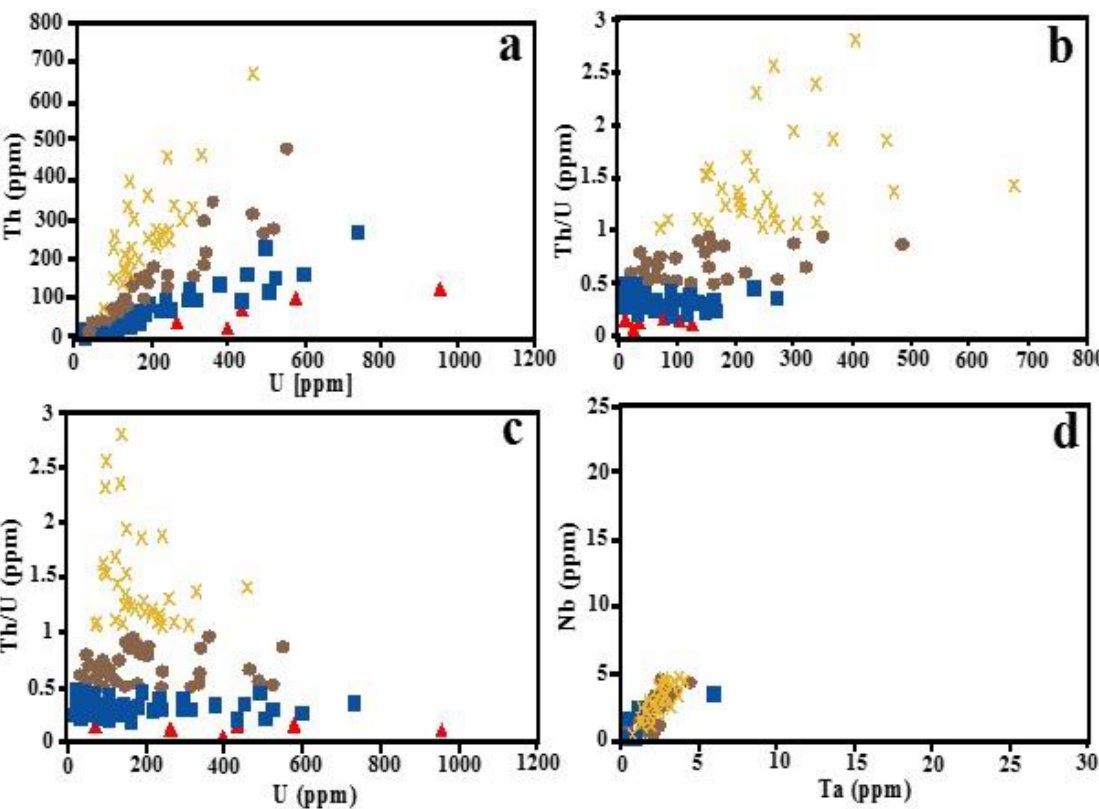
Figure 4. Geochemical correction of various elements/ratios within the southern Meiganga detrital zircons: ( a ) Th versus U; ( b ) Th/U versus Th; ( c ) Th/U versus U; ( d ) Nb versus Ta (red triangles represent zircon with Th/U < 0.2; blue squares represent zircon with Th/U ratios [0.2 to 0.5]; brown circles represent zircons with Th/U ratios [>0.5 to 0.956]; and yellow stars represent zircons with Th/U > 1.0).